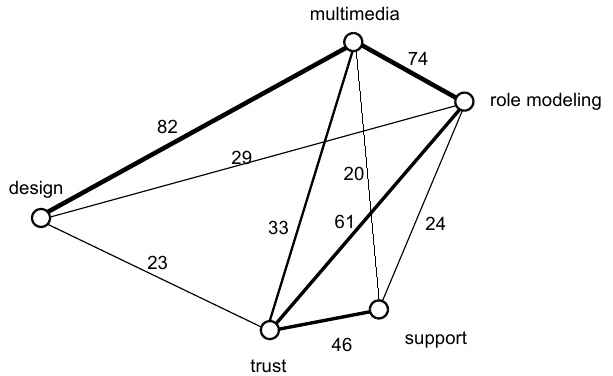
Figure 4. First-order category graph